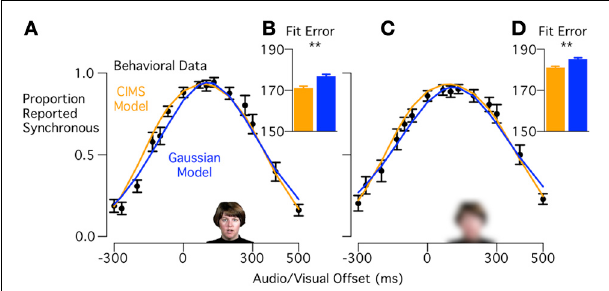
FIGURE 3 | Model fits to behavioral data for experiment 1 (high visual intelligibility words). (A) Black circles show the behavioral data from 16 subjects performing a synchrony judgment task (mean ± standard error) for each stimulus asynchrony with visual reliable, high visual intelligibility stimuli. Curves show the model predictions for the CIMS model (orange) and Gaussian model (blue). (B) Fit error measured with Bayesian Information Criterion (BIC) for the CIMS and Gaussian models; lower values indicate a better fit for the CIMS model ( ∗∗ p = 0 . 006). Error bars show within-subject standard error (Loftus and Masson, 1994). (C) Mean proportion of synchrony responses and model predictions for visual blurred, high visual intelligibility stimuli. (D) Fit error for the CIMS and Gaussian models, showing better fit for the CIMS model ( ∗∗ p = 0 .